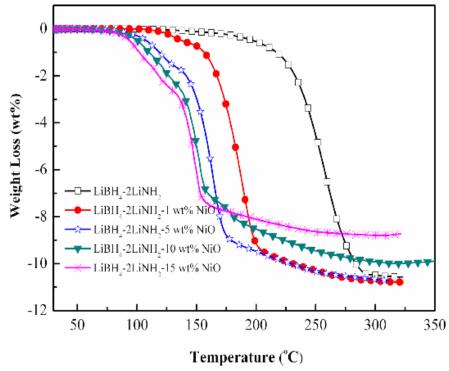
Figure 4. PCT curves of the LiBH 4 -2LiNH 2 - x wt. % NiO samples.